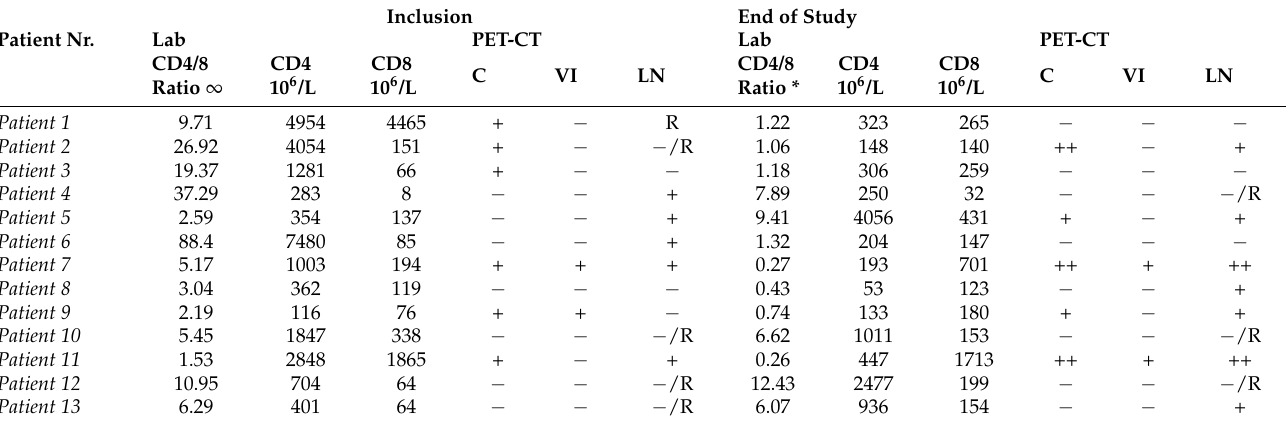
Table 2. Lab and imaging characteristics at inclusion and end of the study